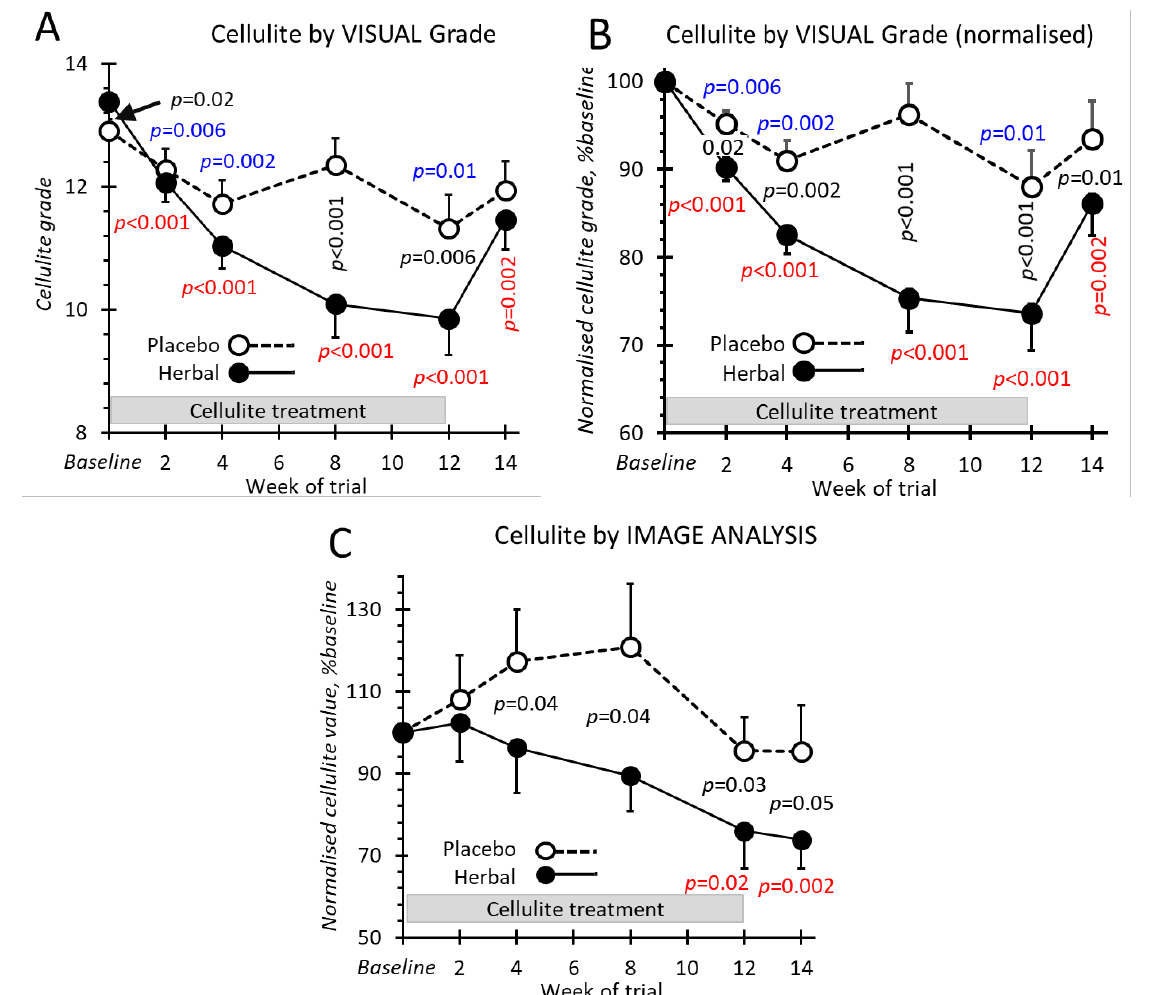
Figure 4. Cellulite changes during the 14 weeks trial. ( A ) Cellulite grades estimated by three blinded independent evaluators. ( B ) Cellulite grades expressed as percentages of the grade before treatment (baseline). ( C ) Normalised cellulite values measured by image analysis. Values are means ± SEMs. p -values in red compare values for herbal gel with corresponding baseline values, those in blue compare values for placebo gel with corresponding baseline values. p -values in black compare herbal and placebo emgel values at the same time point. All statistical testing was performed on data normalised to baseline values for each participant. An absent value indicates p > 0.1. All points are means ± SEM.